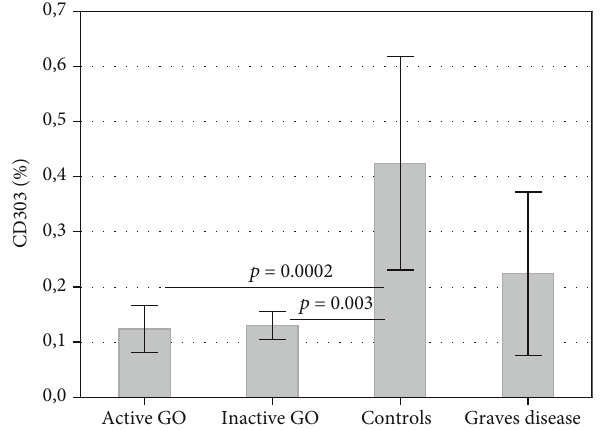
Figure 3: Percentage of pDCs (CD303+) in the peripheral blood of patients with active and inactive GO and controls and GD patients without GO. Data are presented as means ± standard deviation (SD) (ANOVA Kruskal-Wallis test).